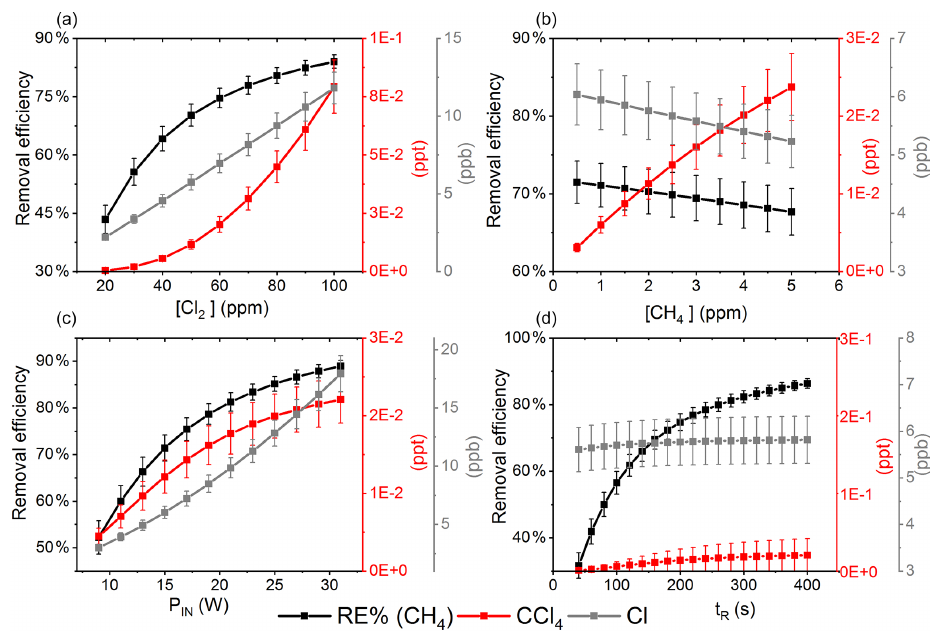
Figure 7. The removal efficiency of methane (black), [CCl 4 ] (red) and [Cl] (grey) is shown in panels (a) – (d) . The four parameters are varied while the remaining parameters are kept at the standard parameter presented in Table 5. (a) The [Cl 2 ] is varied. (b) The initial [CH 4 ] is varied. (c) The J Cl is varied. (d) The t R is varied. 2